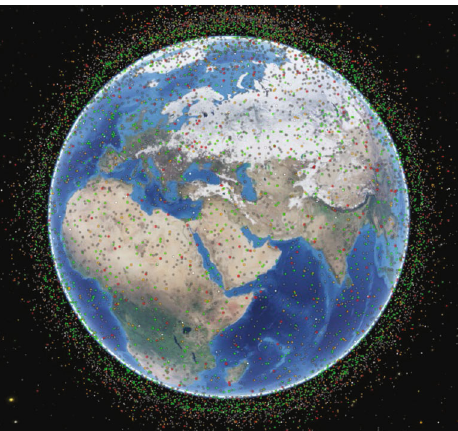
Figure 1: Low orbit space debris distribution